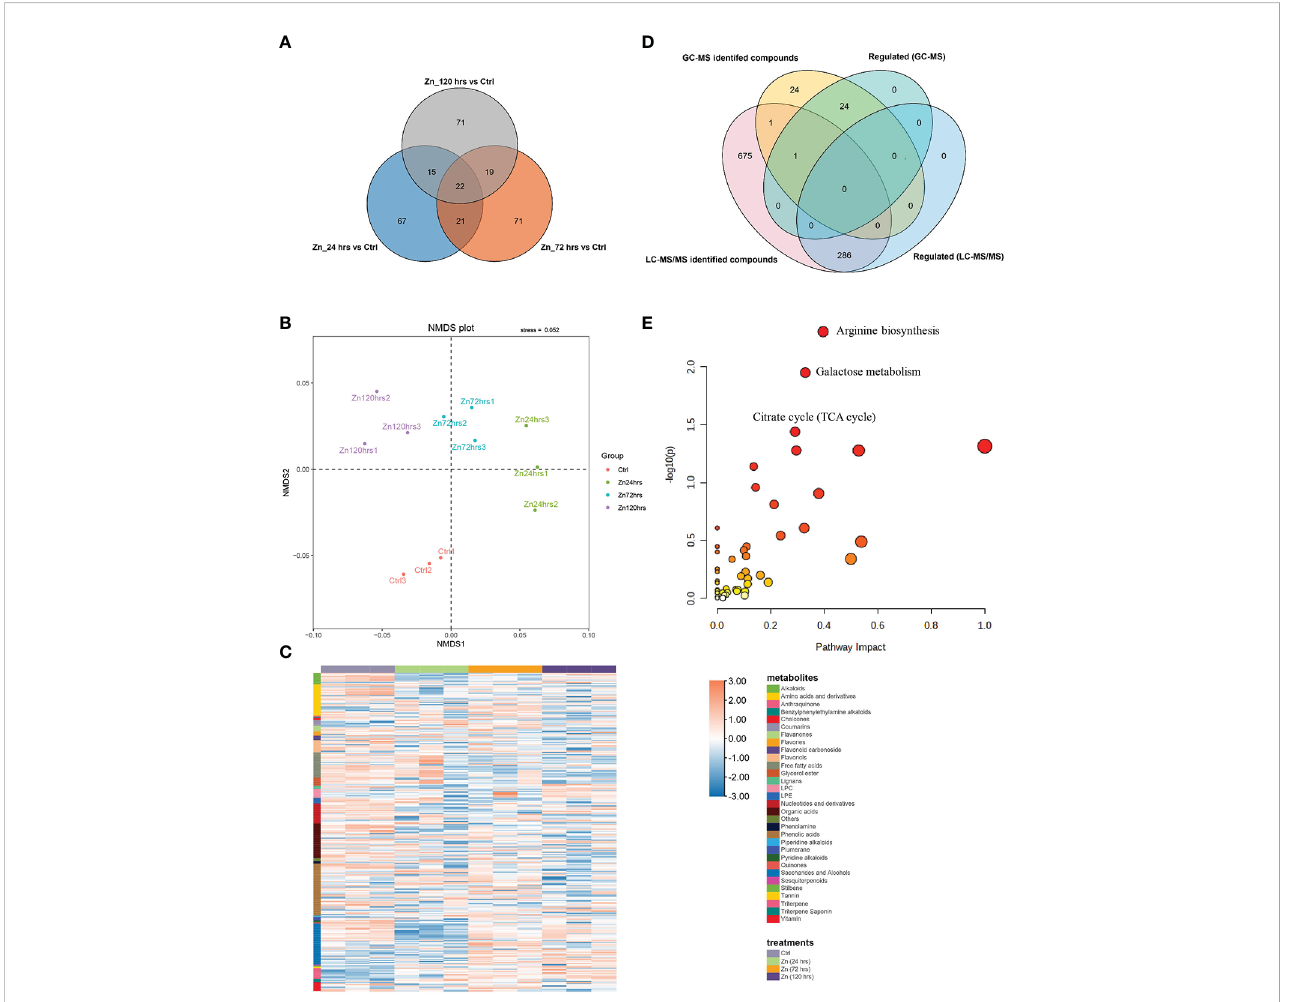
FIGURE 1 Metabolite changes in pumpkin induced by Zn application. (A) Venn diagram indicating the overlaps between the differentially expressed nonvolatile metabolites in the pumpkin at 24 hrs, 72 hrs, and 120 hrs after Zn treatment, respectively (p value < 0.05). (B) NMDS (non-metric multidimensional scaling) analysis represents the rank orders of four experimental conditions after clustering (the stress value was 0.052, which was lower than 0.1). (C) Heatmap generated with the Zn regulated metabolites or substances in the pumpkin. Orange and blue colors separately indicate the relative high or low abundance of metabolites in four different experimental conditions. The column and row banners represent the classi fi cations of different treatments and component classes, respectively. (D) Venn diagram indicating the overlaps between the GC-MS identi fi ed volatiles and LC-MS/MS identi fi ed nonvolatiles in the pumpkin at 24 hrs, 72 hrs, and 120 hrs after Zn treatment, respectively. (E) The scatter plot shows enriched and matched pathways using all regulated compounds that were successfully annotated using the database in MetaboAnalyst (only the top three enriched pathways were labelled). The x and y axes are pathway impact values from the pathway topology analysis, and the corresponding p value from the pathway enrichment analysis,